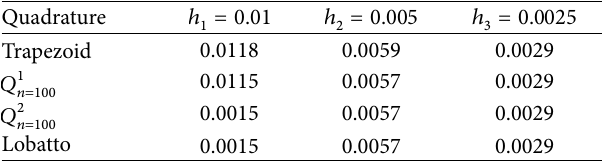
, with and 0.005. 𝑢 ℎ (𝑥) 𝑚 = 500 ℎ = Table 7: Relative errors for different meshes. Example